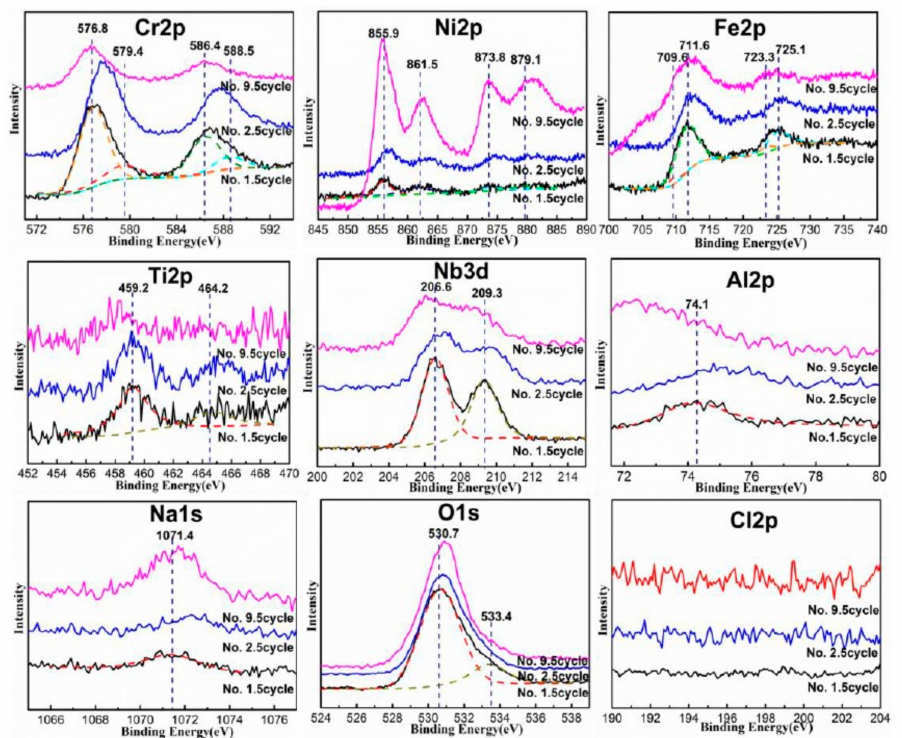
Figure 8. The XPS spectra of Cr 2p, Ni 2p, Fe 2p, Ti 2p, Nb 3d, Al 2p, Na 1s, O 1s, and Cl 2p of corrosion products formed after the No. 1.5 cycle, No. 2.5 cycle, and No. 9.5 cycle.